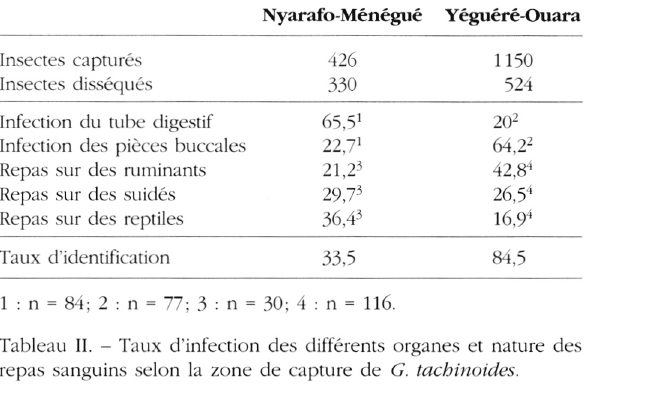
Tableau II. - Taux d’infection des différents organes et nature des repas sanguins selon la zone de capture de G. tachinoides.